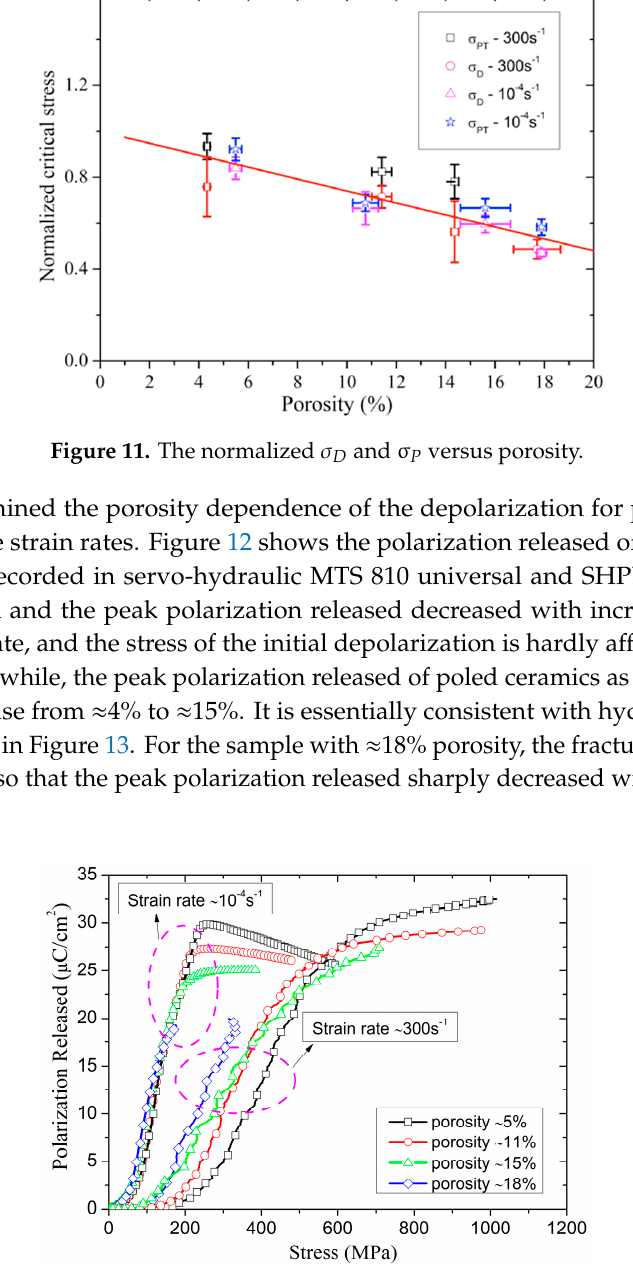
Figure 12. The polarization released of poled ceramics with different porosities under the strain rate of ≈ 10 − 4 s − 1 and ≈ 300 s − 1 as a function of stress.